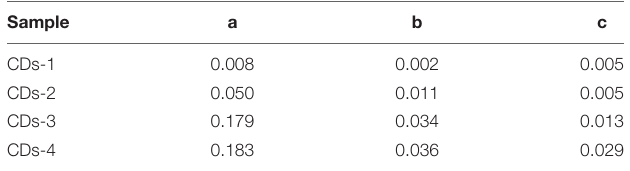
TABLE 2 | The fluorescence quantum yield of different CDs